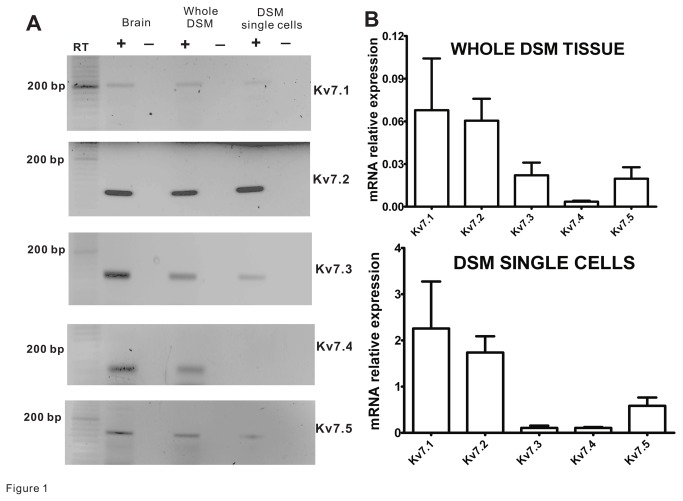
Kv7 channel subtype mRNA expression in guinea pig DSM whole tissue and single-cells.
A) Gel electrophoresis images illustrate RT-PCR detection of all Kv7 channel subtypes including Kv7.1, Kv7.2, Kv7.3, Kv7.4, and Kv7.5 channel mRNA messages in mucosa-free whole DSM tissue (N=4). At DSM single-cell level, unlike other Kv7 channel subtypes (Kv7.1, Kv7.2, Kv7.3, and Kv7.5), the Kv7.4 channel mRNA message was not detected. Guinea pig brain was used as a positive control. No product was observed in the negative controls (-RT) in which reverse transcriptase was not added to the reaction. B) qRT-PCR analysis shows relatively high expression of Kv7.1, Kv7.2, and Kv7.5 subtypes but low (barely detectible) levels of Kv7.4 channel mRNA in both DSM whole tissue (N=4) and DSM single cells (N=4). Data were normalized to GAPDH using the ΔCt method.